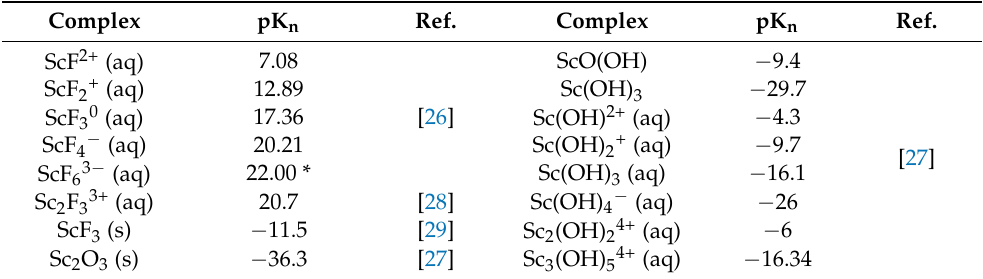
Table 1. Stability constants of Sc complexes and solubility products of Sc